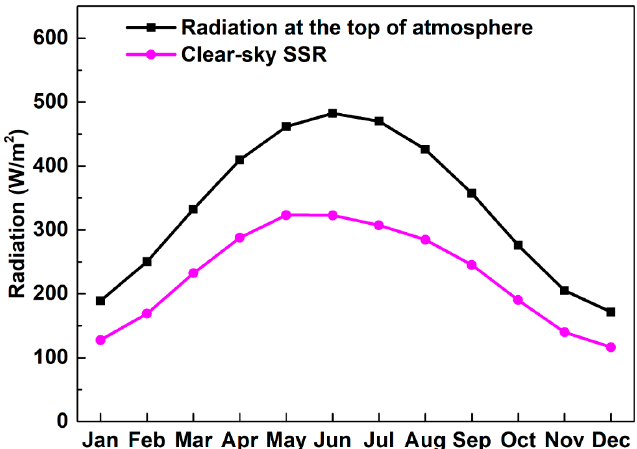
Figure 5. Spatial distribution of seasonal mean clear-sky SSR in northern China from 2001 to 2015: ( a ) Spring; ( b ) Summer; ( c ) Autumn; and ( d ) Winter.